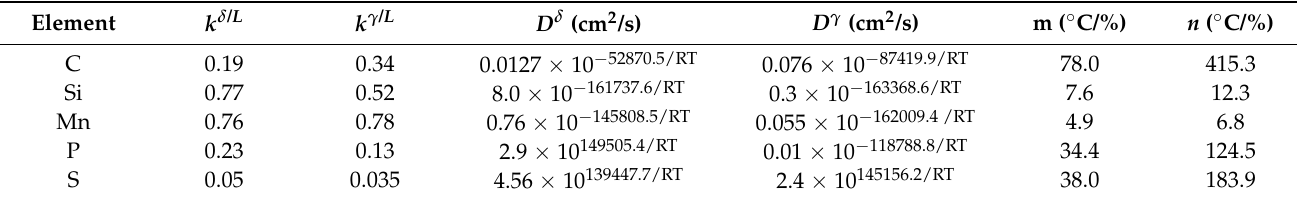
Table 1. Equilibrium partition coefficients, diffusion coefficients, and liquidus line slopes of the solute elements.